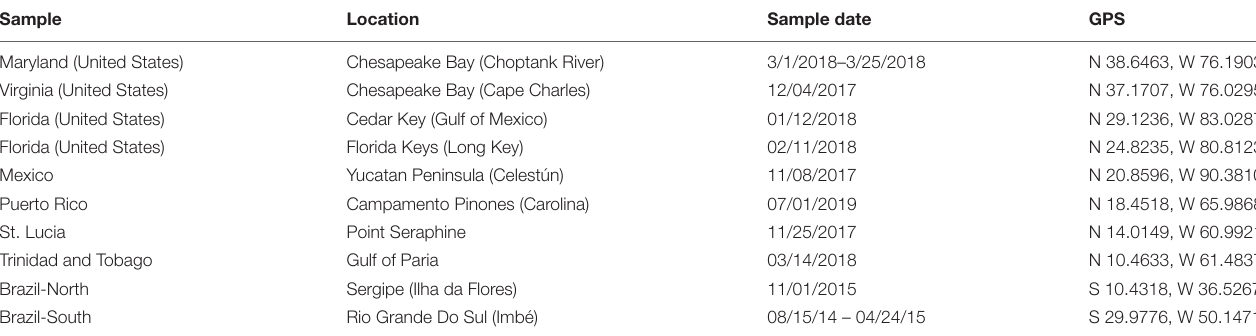
TABLE 1 | Sampling information for Callinectes